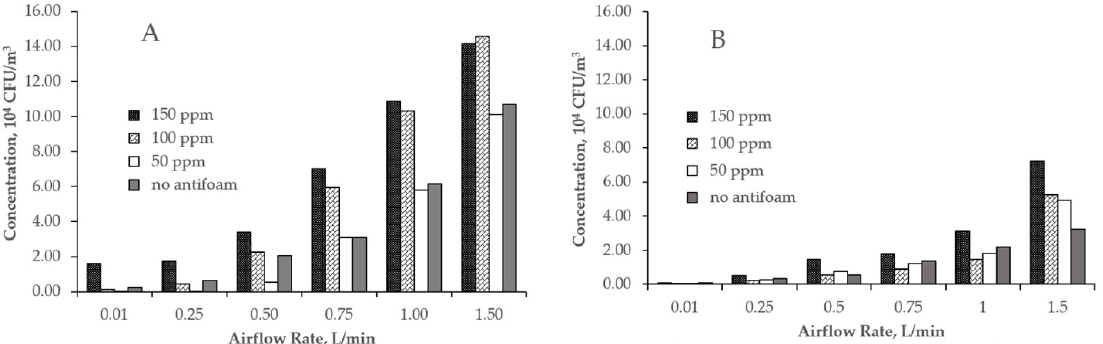
Figure 5. Effect of the antifoam concentrate on the bioaerosol release from the bacterial suspension. ( A ) Small bubbles, ( B ) large bubbles.